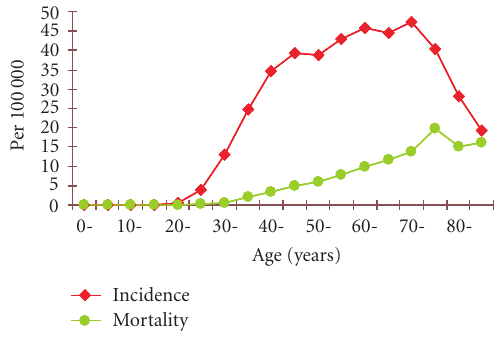
Figure 5: Age-specific incidence and mortality for cervical cancer in